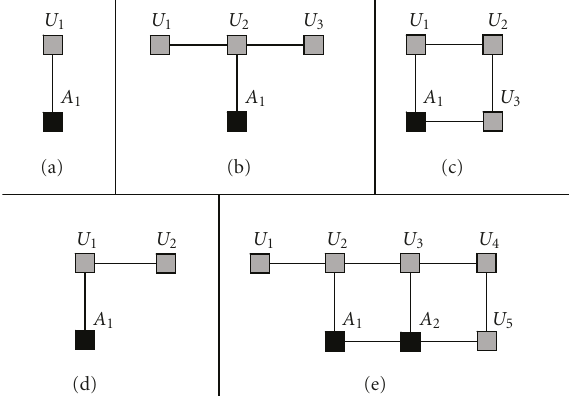
Figure 2: Schematic illustration of atomic unit and collaborative